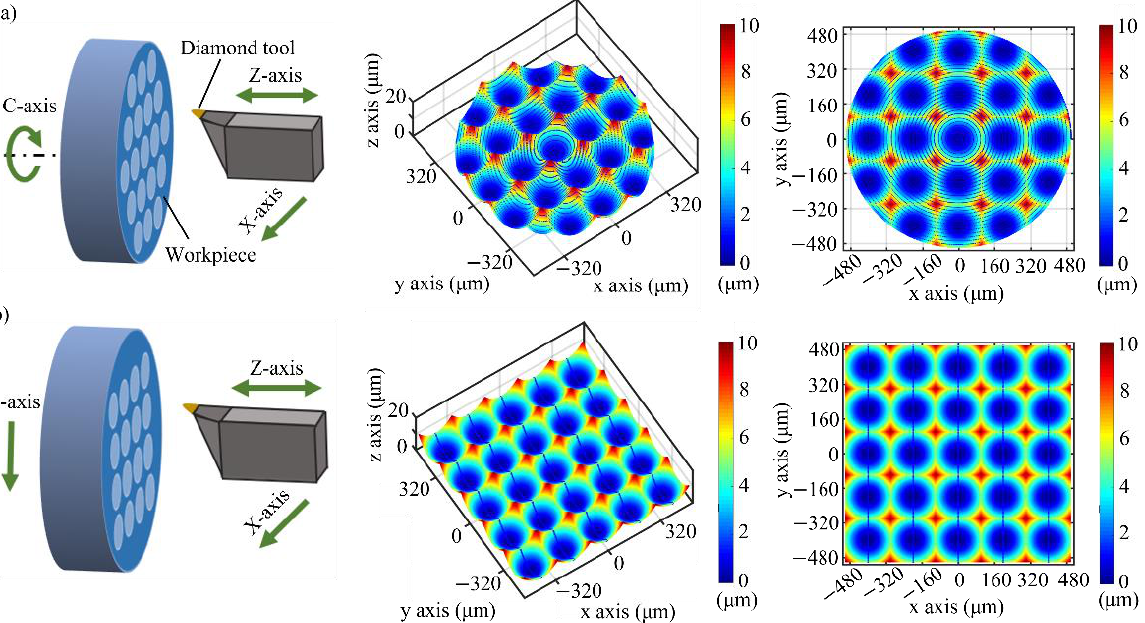
Figure 1. Configuration of the cutting systems and tool paths of microlens array for: ( a ) diamond turning and ( b ) diamond sculpturing.